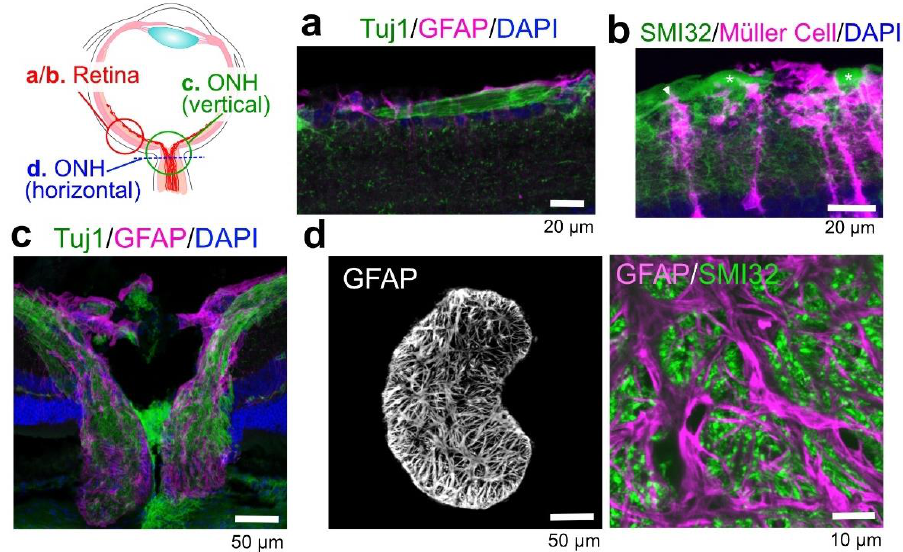
Figure 3. Glial cells in the retina. A schematic showing glial cells in the retina. In addition to retinal neurons (e.g., RGCs, ACs, BPs, HCs, and rod and cone photoreceptors), there are several types of glial cells in the retina. Astrocytes are located at the inner surface of the retina. Müller cells vertically span the entire thickness of the retina. Microglia exist in various neuronal layers, such as the NFL, GCL, IPL, and OPL. NFL: nerve fiber layer; GCL: ganglion cell layer; IPL: inner plexiform layer; INL: inner nuclear layer; OPL: outer plexiform layer; ONL: outer nuclear layer; IS/OS: inner or outer segment of photoreceptors; RGC: retinal ganglion cell; AC: amacrine cell; BP: bipolar cell; HC: horizontal cell.